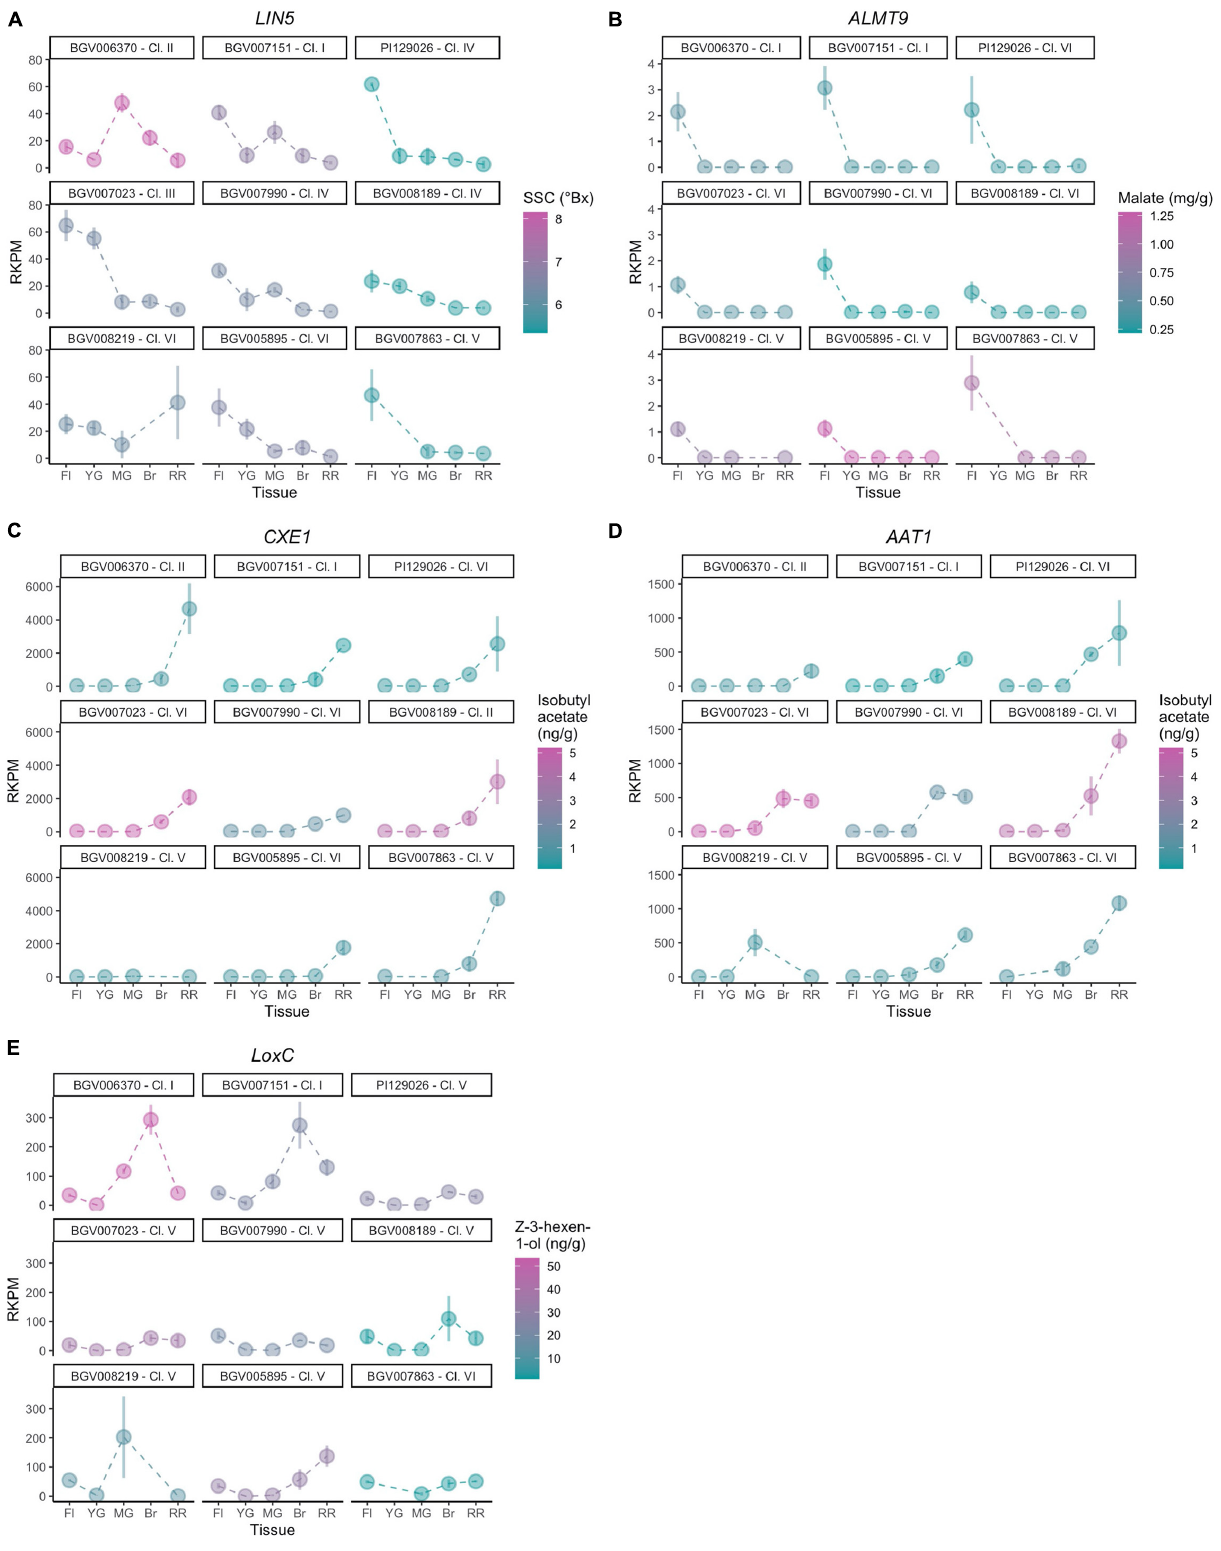
Frontiers in Plant Science |